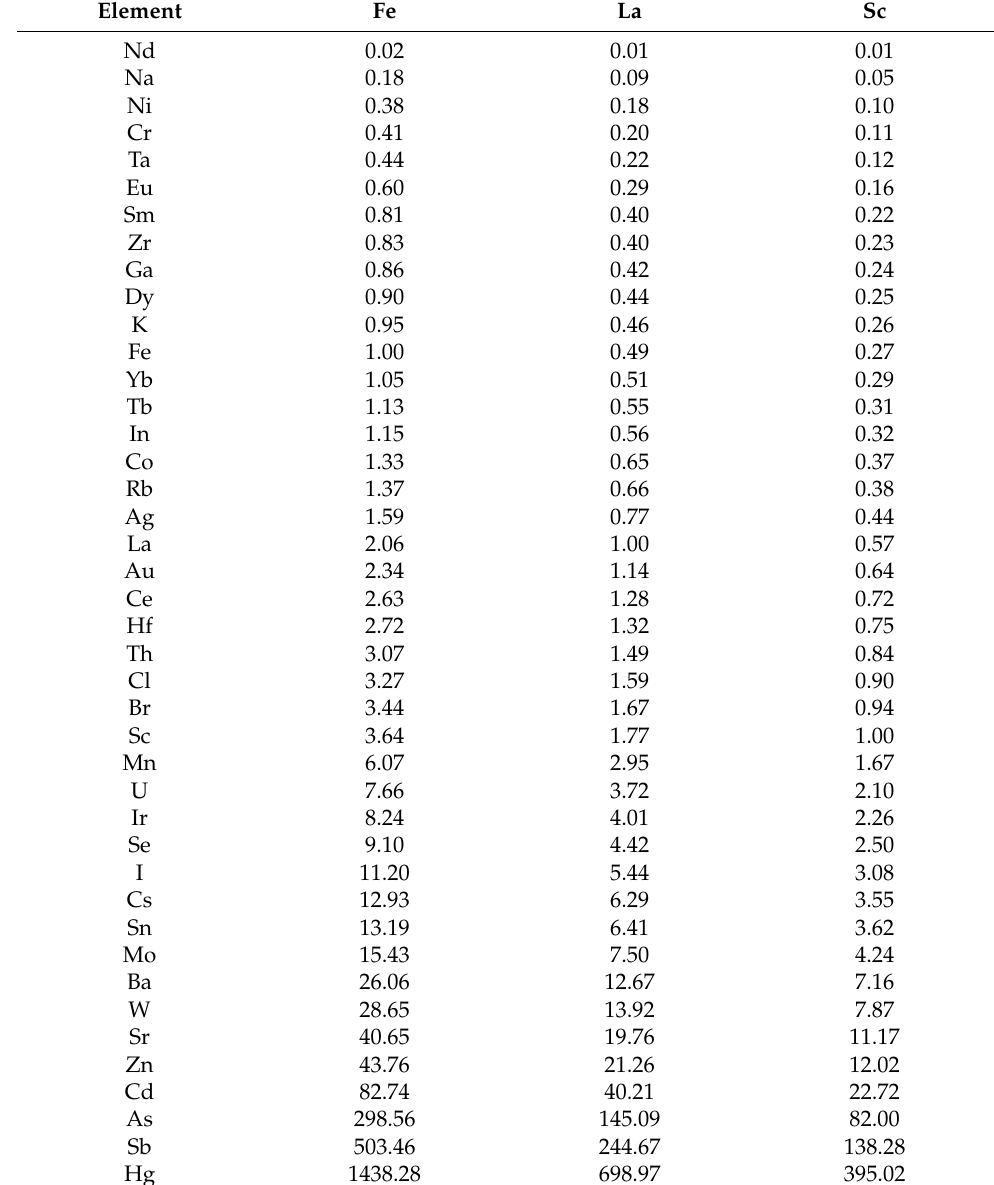
Table 7. Synoptic table of the calculated enrichment factors (EFs) (ordered in ascending order) for overall the elements (Fe, La, Sc normalizing